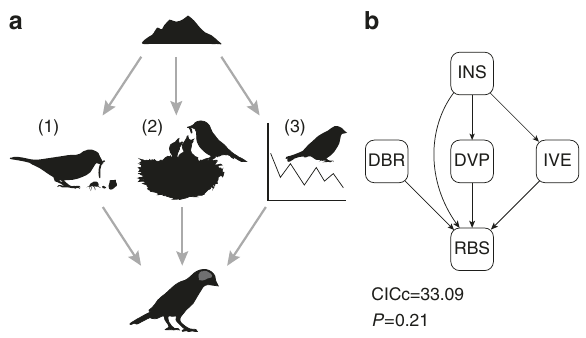
Fig. 3 Alternative mechanisms behind changes in relative brain size in islands. a Different factors could be mediating the evolution of larger relative brains on islands. Niche expansions (1), changes in life history (2) and increased environmental variation (3). b The best-supported path model (lowest CICc) suggests that life history and environmental factors are mainly responsible for brain expansions. Abbreviations: INS insularity, DBR diet breadth, DVP developmental period, IVE inter-annual variation in environmental productivity, RBS relative brain size. P > 0.05 indicates that the model fi ts the data. Silhouettes were drawn by